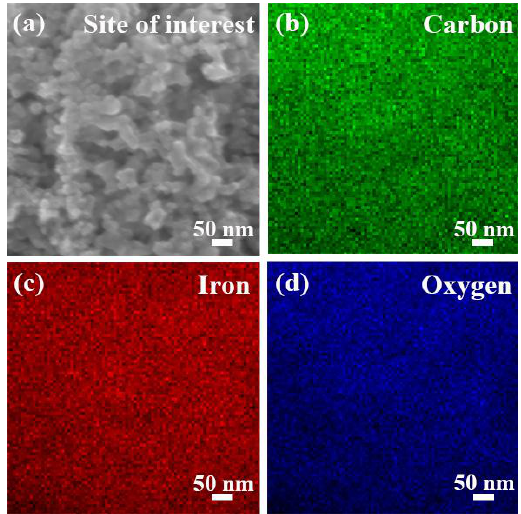
Figure 4. SEM image ( a ) of the C@Fe 2 O 3 composite and corresponding carbon ( b ), iron ( c ), and oxygen ( d ) element mapping.